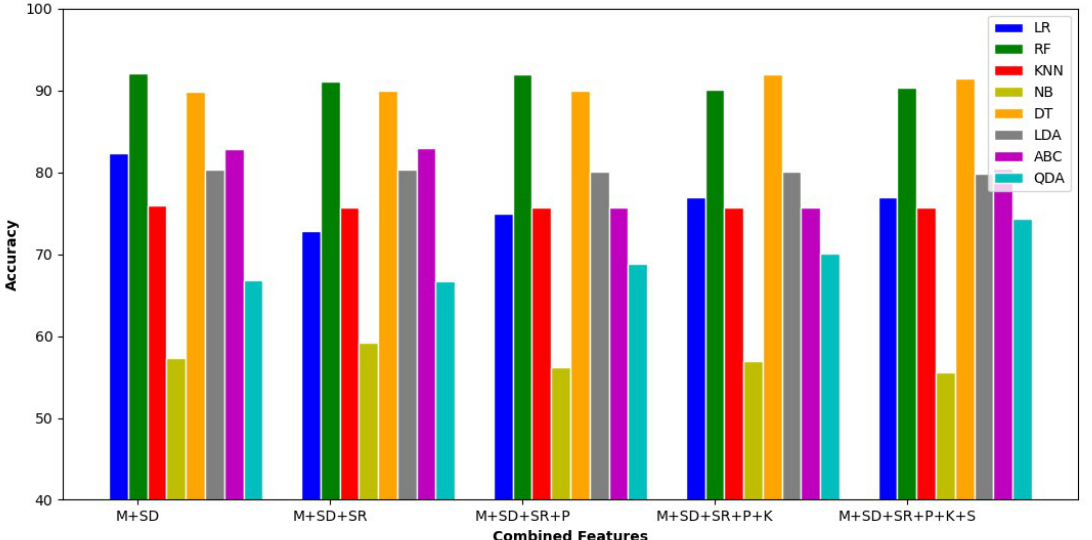
Figure 3. Experimental results for feature